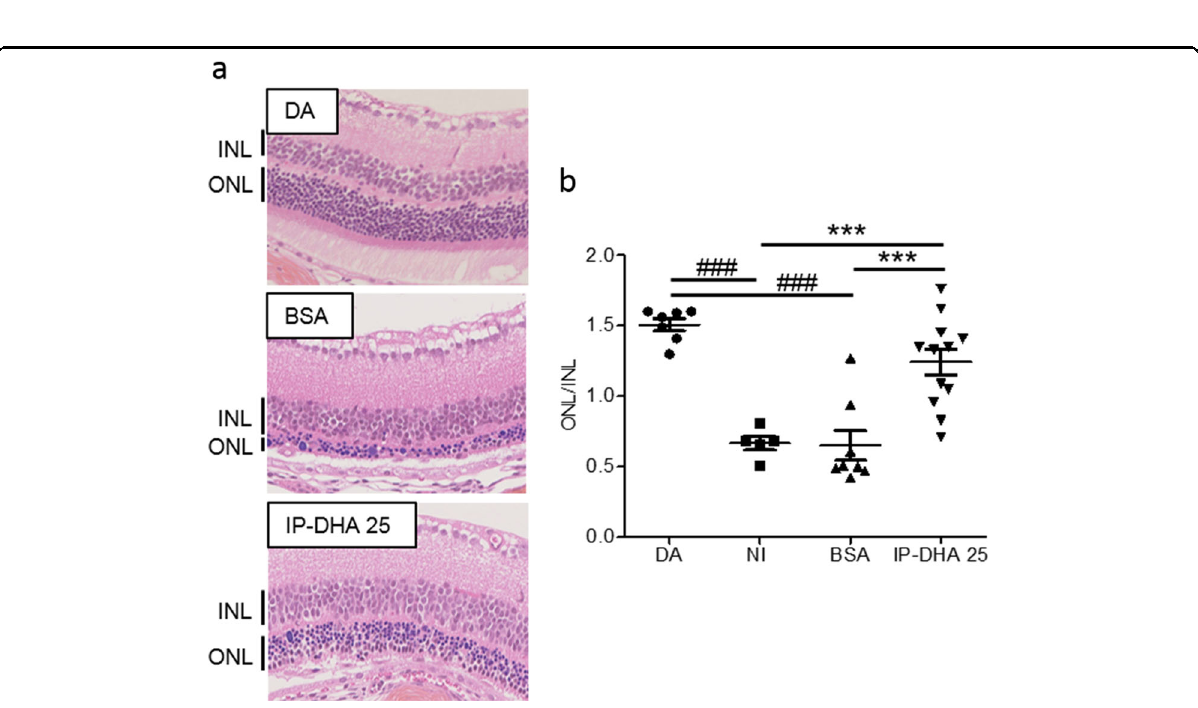
Fig. 2 Histological analysis of retinae after light-induced acute retinal degeneration. a HES staining of retinal sections from Abca4 − / − mice that were dark-adapted (DA) or injected with BSA (BSA) or 25 mg/kg IP-DHA (IP-DHA 25) before light exposure. b IP-DHA treatment prevented the thinning of the outer nuclear layer (ONL), which contains photoreceptors, in untreated or BSA-treated mice. The data are presented as scatterplots, and horizontal bars indicate the mean ± SEM from n ≥ 6 mice. One-way ANOVA with Bonferroni ’ s test: ### p < 0.001 vs. DA; *** p < 0.001 vs